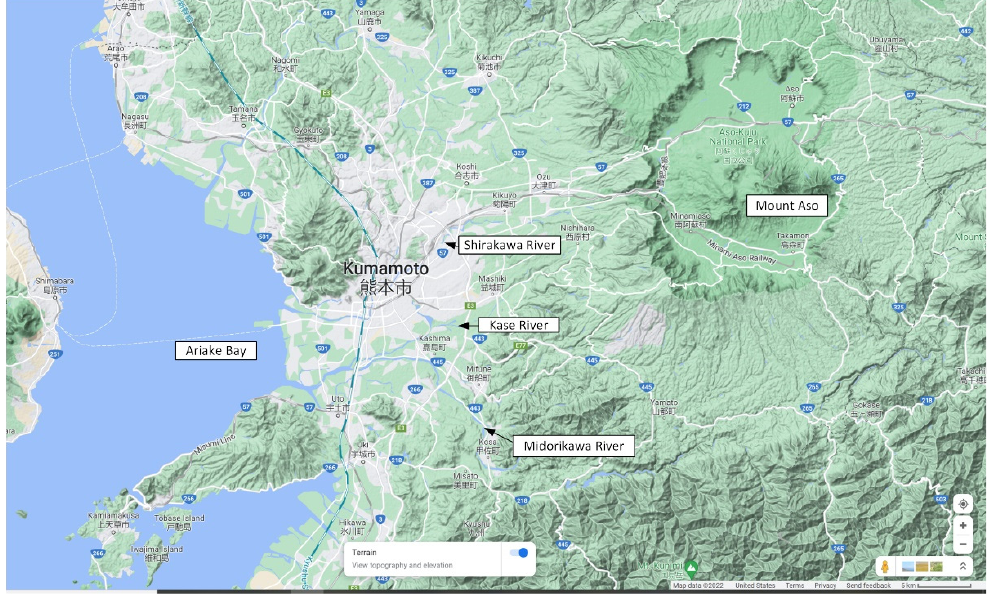
Figure 1. Site vicinity map of the Kumamoto Plain and Mount Aso (courtesy of Google Maps).